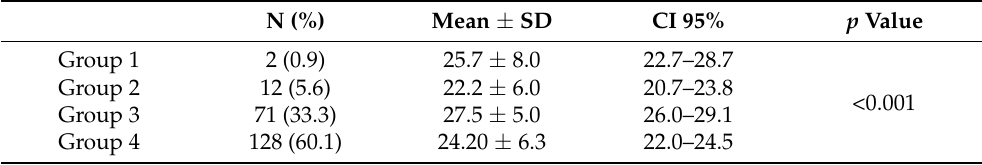
Table 4. Clinical phenotypes of respiratory drive.